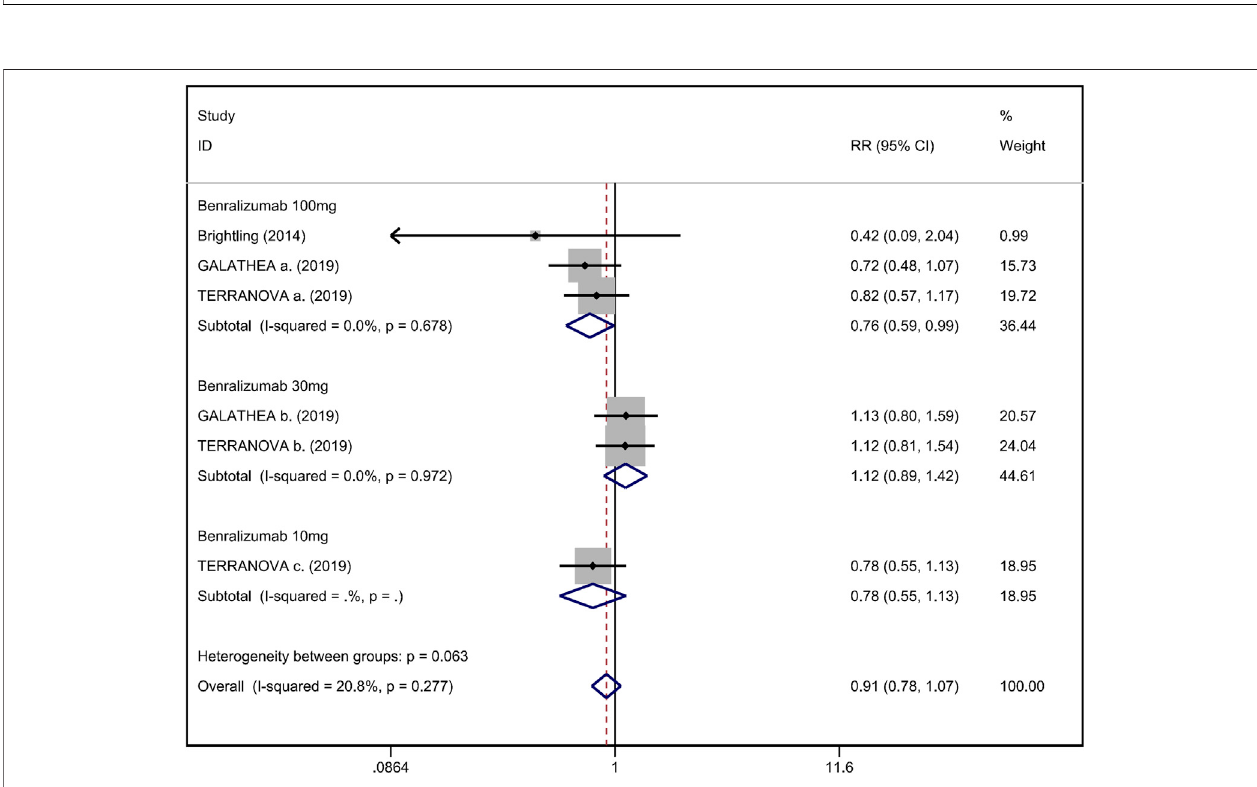
FIGURE 5 | Forest plot of hospital admission rate for acute exacerbation in eosinophilic COPD patients with anti-IL-5 therapy vs. placebo.